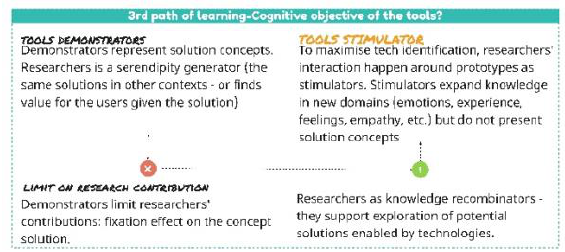
Fig. 15. Cognitive objective of the N2T